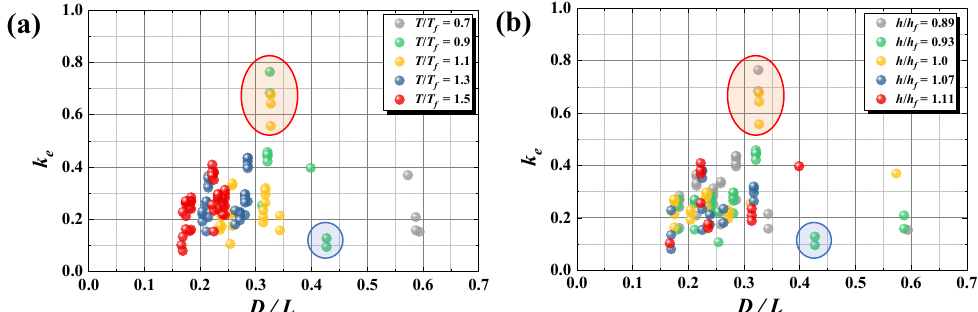
Figure 14. Relationship between k e and D / L depending on ( a ) T / T f , and ( b ) h / h f . Open red and blue circles denote the range of high and low k e , respectively, owing to the effects of D/L.